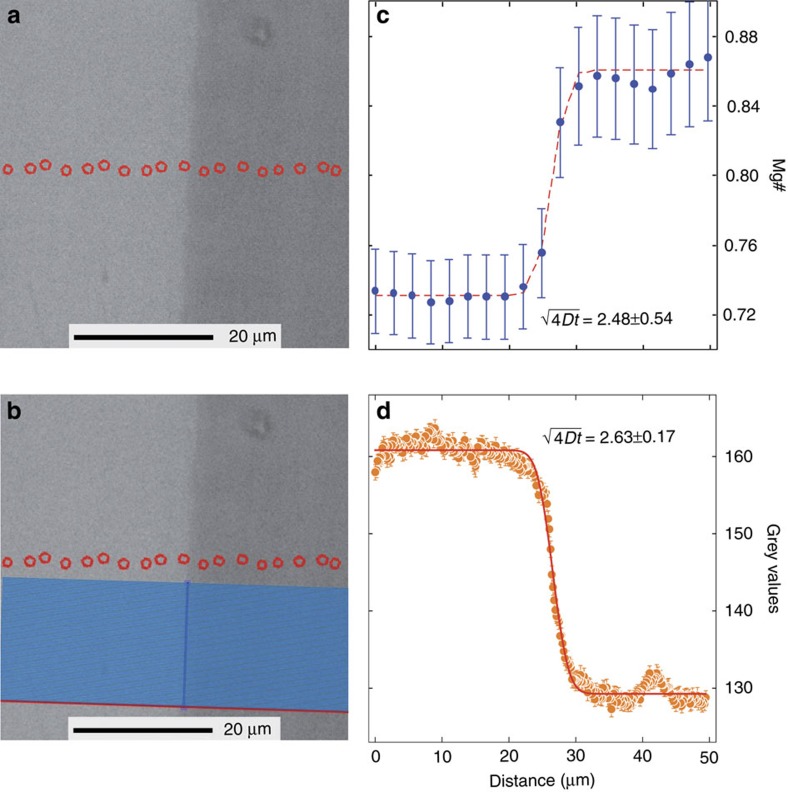
Electron microprobe versus greyscales profile.The electron microprobe compositional profile (a,c) is used to calibrate the grey scale profile (b,d) along the clinopyroxene compositional boundary. We used BSE greyscale values as a proxy of Mg# variations in clinopyroxene on the basis of the identical, within error, fitting parameter (that is, =2.63±0.17 for the grey value and 2.48±0.54 for Mg#) obtained using both the greyscale (red line in d) and Mg# (red line in c) diffusion profile (Methods). (a) BSE-SEM image of the compositional boundary of a clinopyroxene analysed in this study. The red dots mark the single point analysis of the electron microprobe profile; (b) Same image as in a showing the grey values raster (blue lines) calculated parallel to the electron microprobe profile (red dots), using the ‘greyscale calculation’ code (Methods). The raster (light parallel blue lines, the first line of the raster is reported as single red line) is perpendicular to the guideline (single bold blue line) drawn parallel to the boundary layer (Methods); (c) Mg# versus distance (μm) compositional profile, along the traverse (red dots in a), of the clinopyroxene shown in a. The red line is the best fitting of the compositional profile. Error bars (2 s.d.) in Mg# values represent error propagation uncertainties of electron microprobe analyses; (d) Grey value versus distance (μm) compositional profile, along the raster (blue lines in b) of the clinopyroxene shown in b. The red line is the best fitting of the diffusion profile as calculated with the NIDIS. The grey value profile is the average of 100 profile lines; error bars represent the 2 standard error of the mean (2 s.e.).